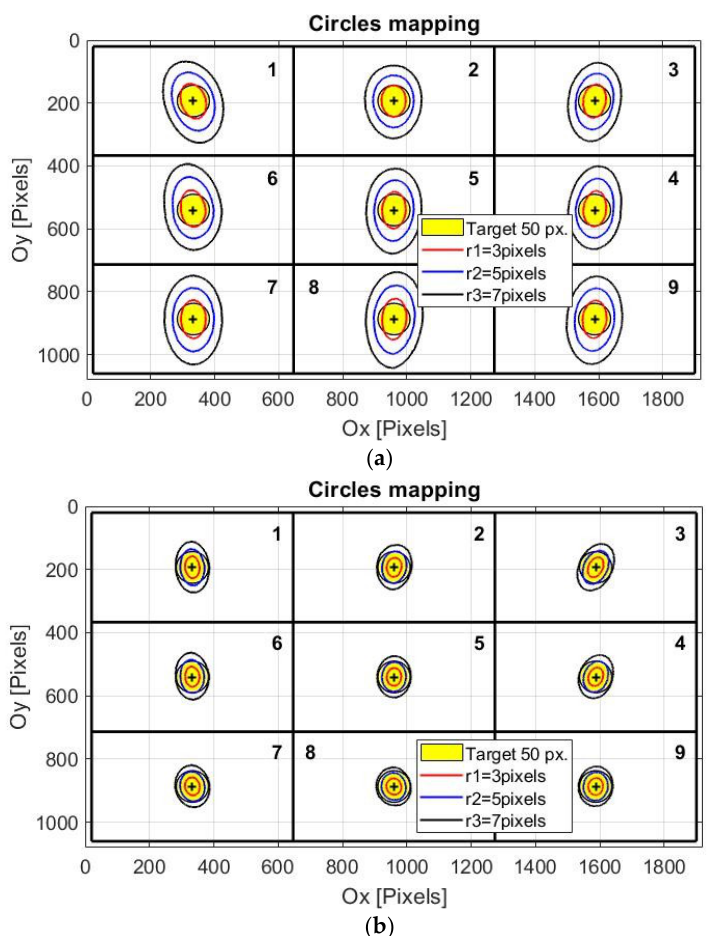
Figure 3. Mapping results on the scene image (user screen) for circles with radii of 3, 5, and 7 pixels in the raw eye image: ( a ) low accuracy of the calibration procedure (mapping rate (MR) = 15.96); ( b ) high accuracy of the calibration procedure (MR = 8.86).